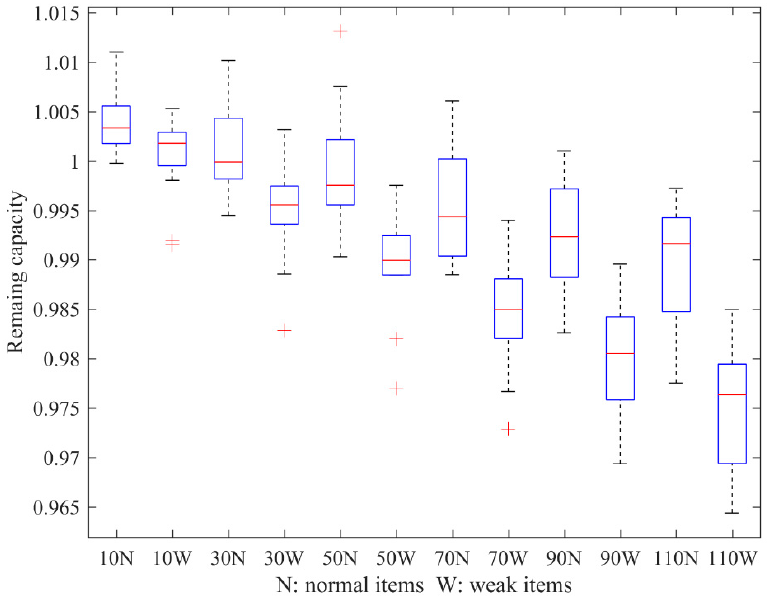
Figure 5. Box plots of remaining capacity.